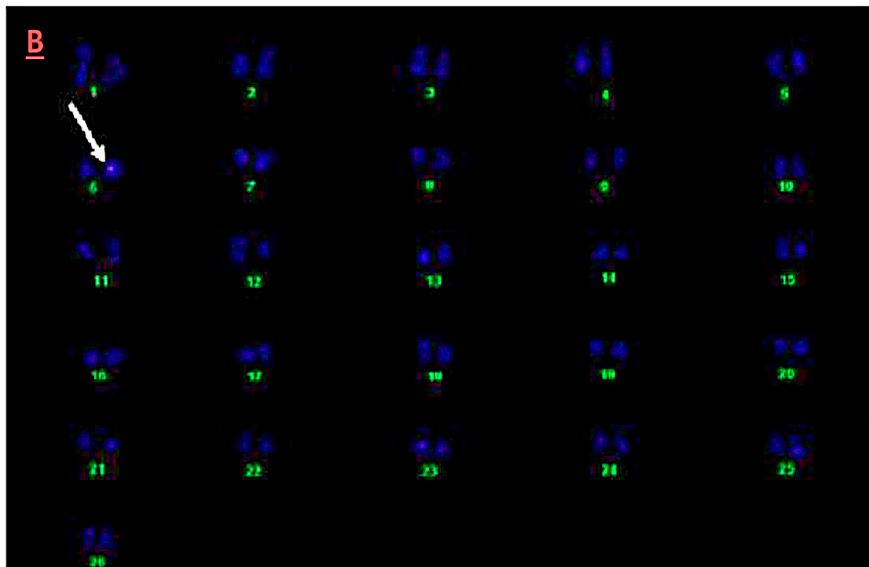
Figure 7. Fluorescence in situ hybridization (FISH) of the dsRNA hairpin construct in T 1 generation plants. ( A ) Metastatic data for T 1 transgenic cotton plants. The arrow indicates the location of transgene integration, as visualized by hybridization with a sequence-specific probe and fluorescent microscopy; ( B ) Karyotyping of a transgenic cotton plant V β 6 in the T 1 generation. The arrow indicates the location of the transgene on chromosome 6, visualized after chromosomes were re-ordered consecutively, using the karyotyping software Cytovision Genus version 3.93 Applied Imaging USA.